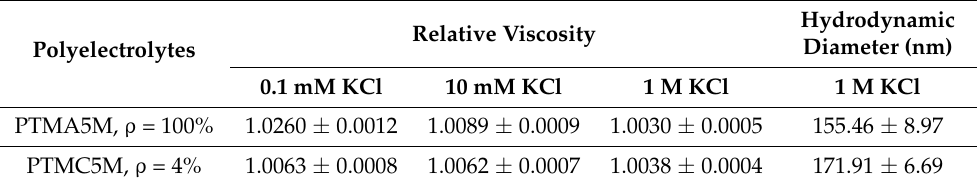
Table 1. Relative viscosity and hydrodynamic diameter of PTMA5M and PTMC5M at 5 ppm determined by Einstein’s equation at different KCl concentrations [27]. The standard deviations were calculated by at least eight